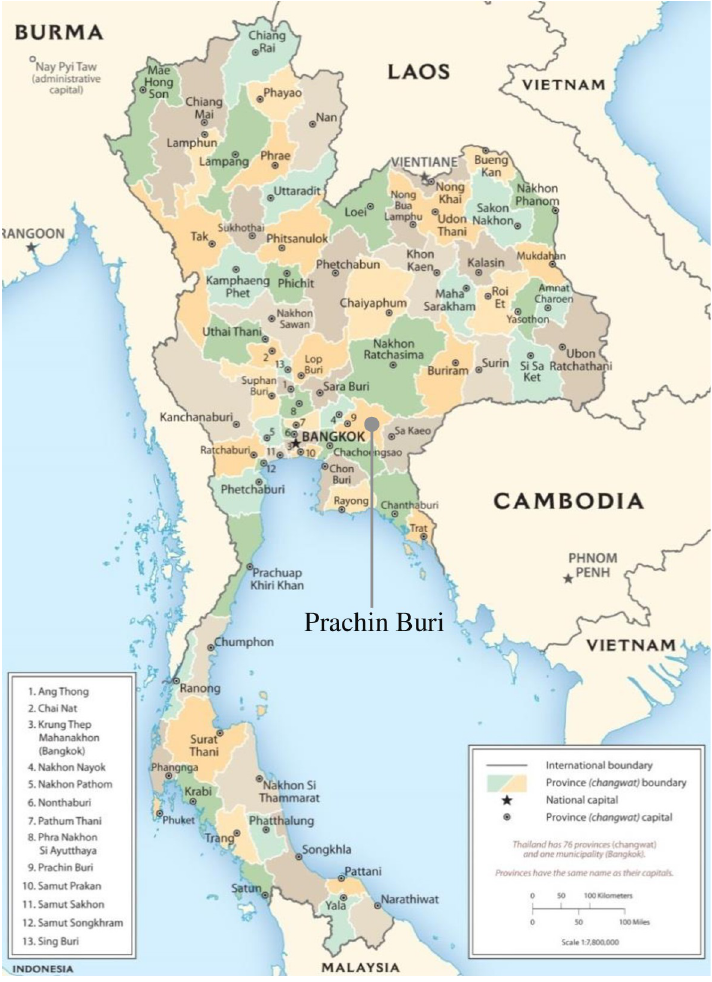
Fig 2. Study area in Prachin Buri province, Thailand. Note: Adapted from map produced by the U.S. Central Intelligence Agency; source: https://www.cia.gov/resources/map/thailand/.